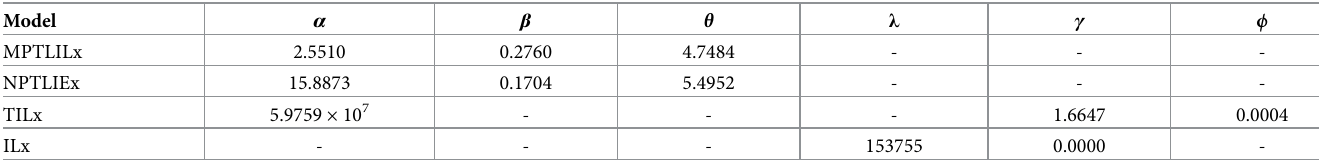
Table 2. Estimates of the hailing times data using MLEs. Model